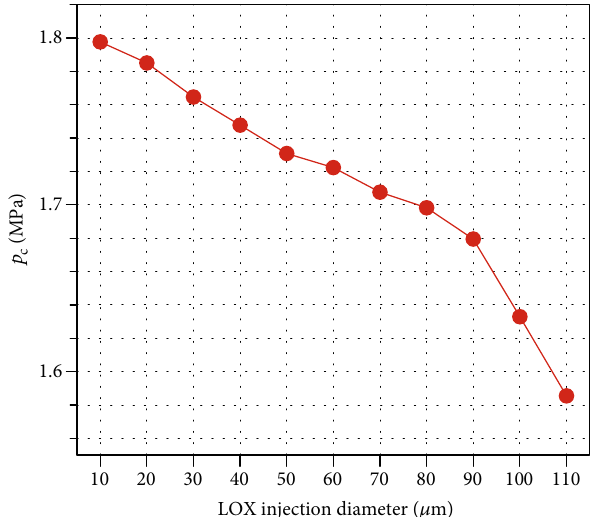
Figure 12: Combustor pressure for di ff erent initial LOX particle